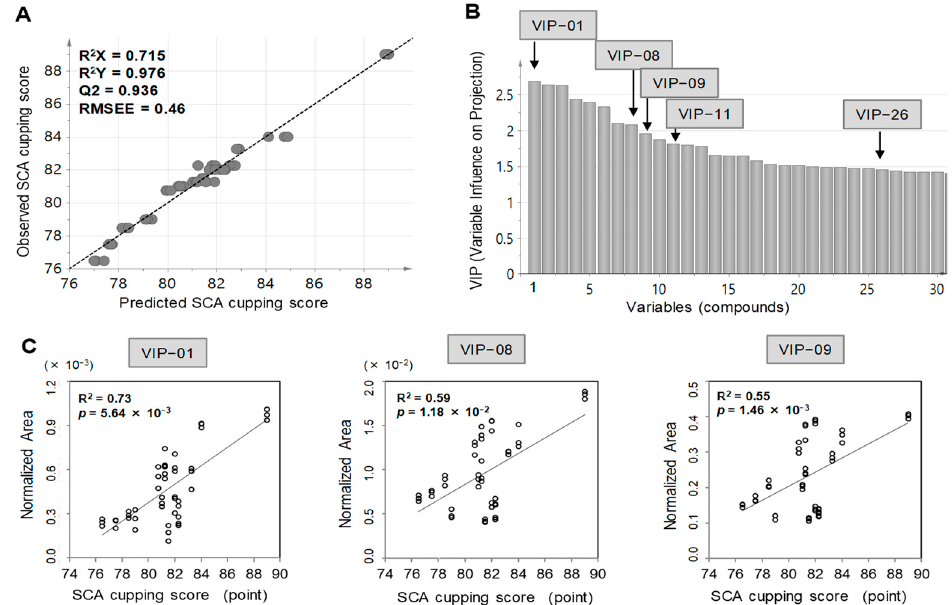
Figure 1. MECs strongly correlated with the SCA cupping score studied by non-targeted analysis. ( A ) OPLS model. The SCA cupping score was predicted by chemical information. ( B ) VIP plots. The top 30 variables (compounds) are shown. Arrow heads indicate MECs. ( C ) Correlation plots between the SCA cupping score and the GC–MS normalized area of VIP-01 ( left ), VIP-08 ( center ), and VIP-09 ( right ).